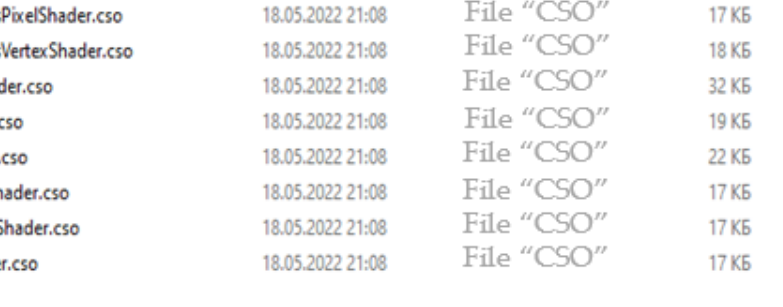
Figure 19. SHADERS